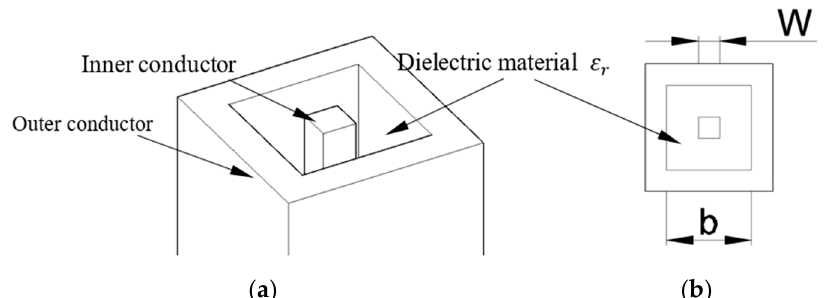
Figure 1. ( a ) A 3D isometric view of the square-coaxial line filled with dielectric material between inner and outer conductors; ( b ) dimensions of the square-coaxial line and ε r is the relative dielectric constant of the filled material.